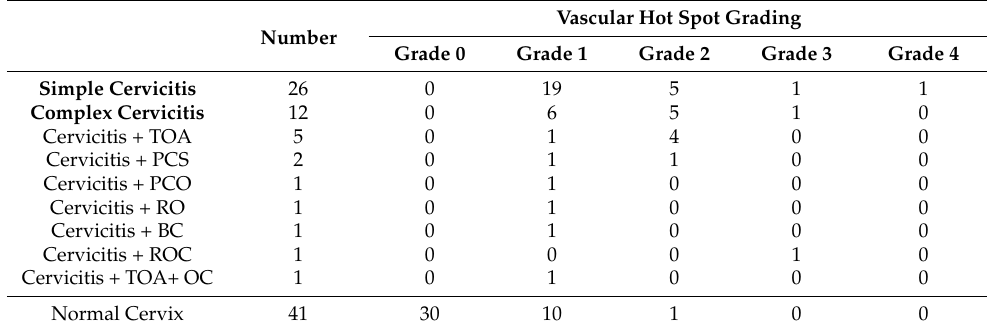
Table 1. The characteristics of case group and control group in Vascular Hot Spot Grading System by using